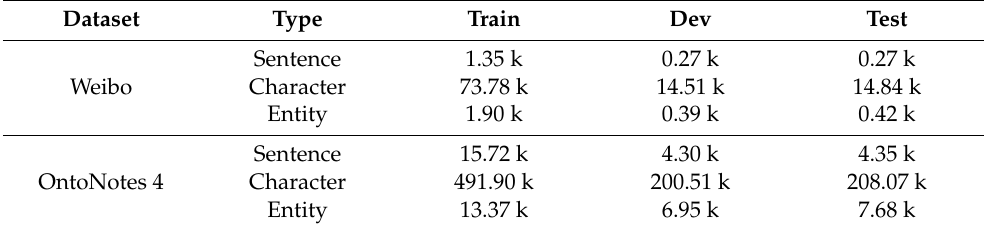
Table 1. Statistics of the